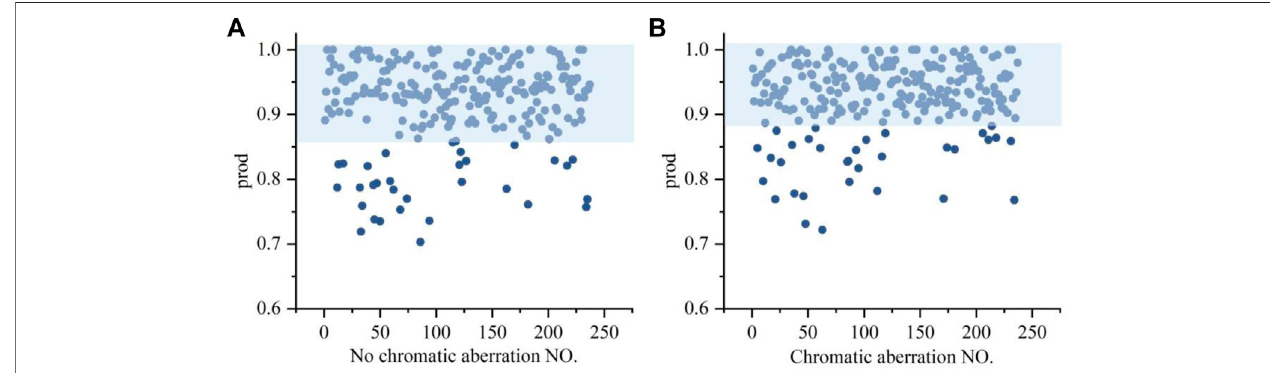
FIGURE 12 | Generalization prediction prod statistics results of FFC chromatic aberration experimental data: (A) No chromatic aberration prod (B) Chromatic aberration prod.